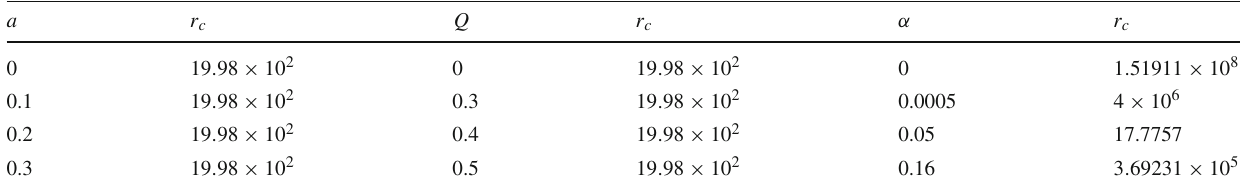
Table 10 Cosmological horizon r c for ω = − 1